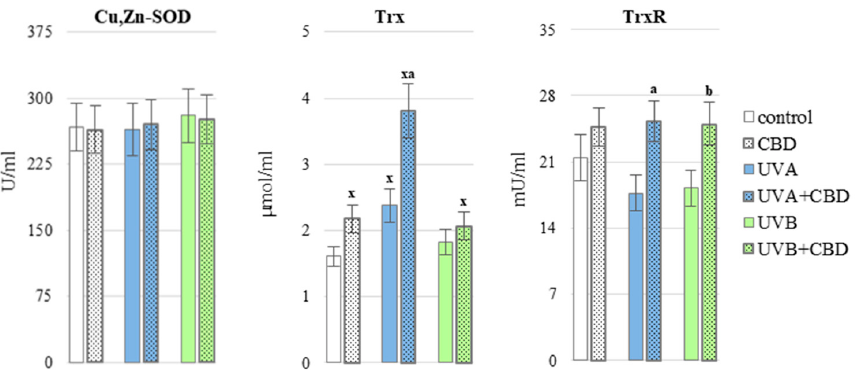
Figure 3. The activity of superoxide dismutase (Cu, Zn-SOD) as well as the level of thioredoxin (Trx) and the activity of thioredoxin reductase (TrxR) in the blood plasma of nude rats in the following groups: control; treated with CBD (every 12 h) for 4 weeks; irradiated with UVA (every 48 h) for 4 weeks; irradiated with UVA (every 48 h) and treated with CBD (every 12 h) for 4 weeks irradiated with UVB (every 48 h) for 4 weeks; irradiated with UVB (every 48 h) and treated with CBD (every 12 h) for 4 weeks. The mean values for six rats in each group ± SD are shown: x—differences vs. control group, p < 0.05; a—differences vs. UVA treated group, p < 0.05; b—differences vs. UVB treated group, p < 0.05.